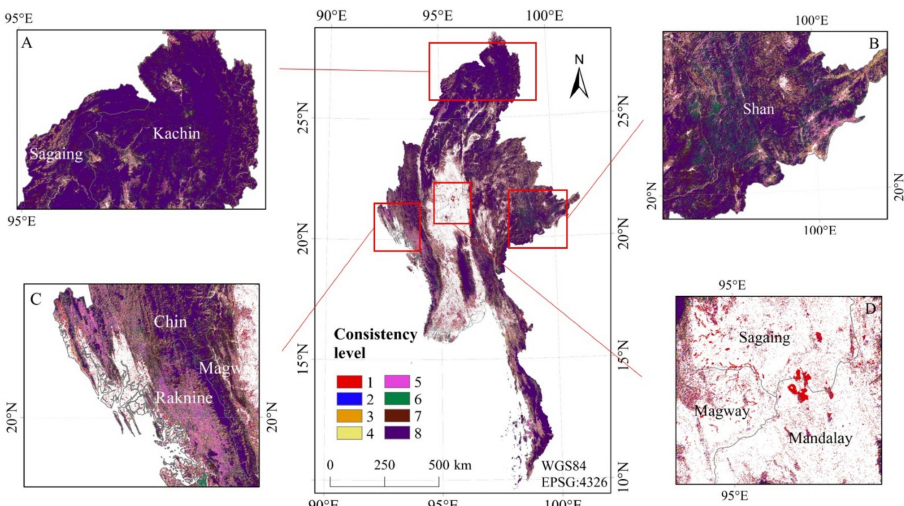
Figure 6. Spatial consistency of eight datasets in Myanmar. Full agreement corresponds to a value of 8 (all eight datasets agree), and full disagreement corresponds to a value of 1 (only one dataset identifies forest). White corresponds to non-forest for all datasets. Sub-area ( A – D ), respectively, are the details of the consistency distribution for four major regions (( A ) is the area of the best consistency, ( B ) is the area of good consistency, ( C ) is the area of poor consistency, ( D ) is the area with “salt and pepper”).